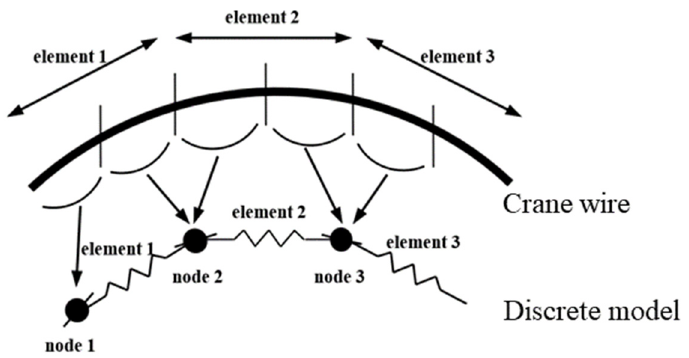
Figure 1. The lumped mass model.